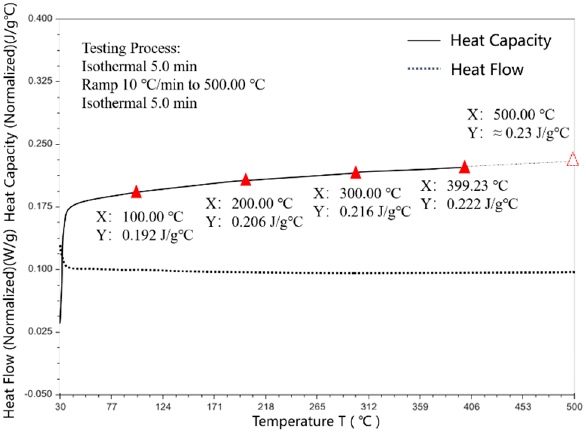
Figure 1. Specific heat capacity data between 30 and 400 °C.